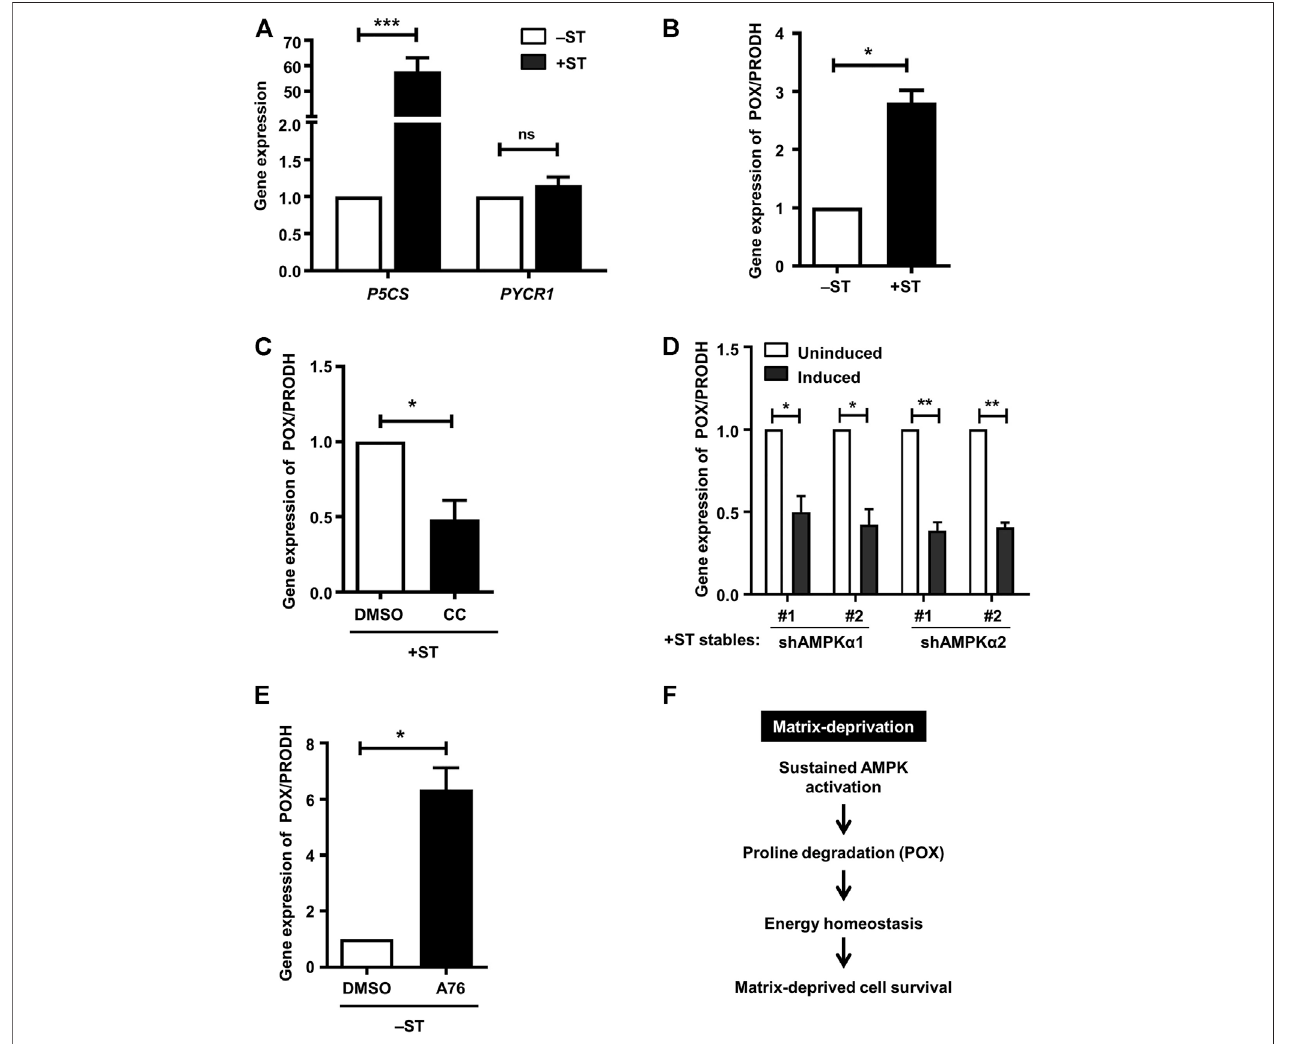
FIGURE 4 | AMPK activation positively regulates proline oxidase: (A) Adherent − ST and +ST cells were harvested for qPCR analysis of P5CS and PYCR1. Graph represents fold change of gene expression normalized to housekeeping gene β 2M. Error bars represent mean ± SEM; n (cid:1) 4. (B – E) qPCR analysis was done for expression of POX/PRODH under the following conditions: (B) Adherent − ST and +ST cells cultured for 24 h, n (cid:1) 3; (C) Adherent + ST cells treated with AMPK inhibitor compound C (CC; 10 μ M) or vehicle control DMSO for 24 h; n (cid:1) 4; (D) Adherent +STcells stably expressing the speci fi ed shRNA under Tet-on inducible promoter induced with 5 µg/ml doxycycline for 48 h; uninduced cells were used as control; n (cid:1) 3; (E) Adherent − ST cells treated with AMPK activator A-769662 (A76; 150 μ M) or vehiclecontrolDMSOfor24 h; n (cid:1) 3.Allgraphsrepresentfoldchangeofgeneexpression normalized tohousekeepinggene β 2M.Errorbarsrepresentmean ± SEM. (F) Sustained AMPK activation promotes energy homeostasis and matrix-deprived survival via regulation of POX expression and thus proline metabolism.